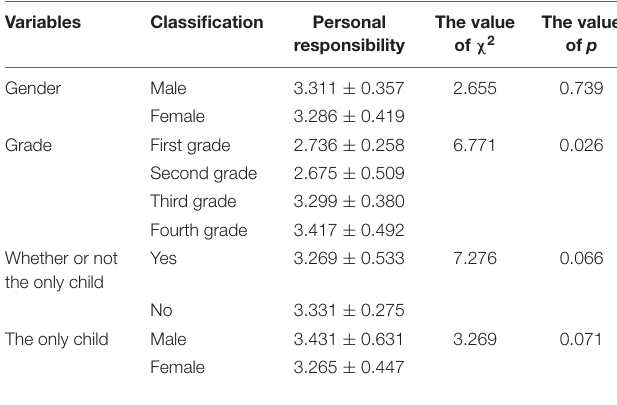
TABLE 4 | An analysis of the difference of personal responsibility in general demographic